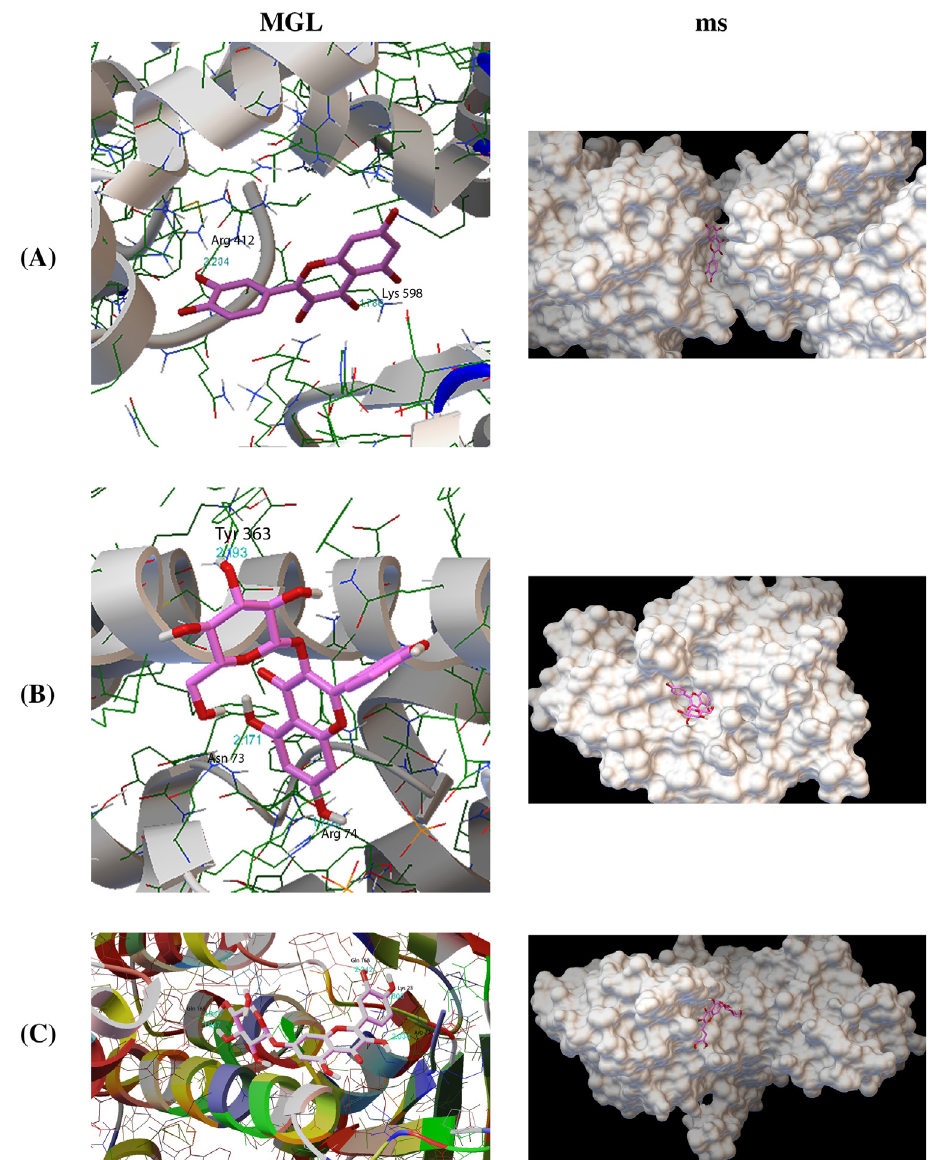
FIGURE 3 - The chemical interaction between the proteins and the ligands visualized using MGL tools and molecular surface (ms), where: (3A) HPGDS and quercetin, (3B) FPPS and astragalin, (3C) DCK and quercetin